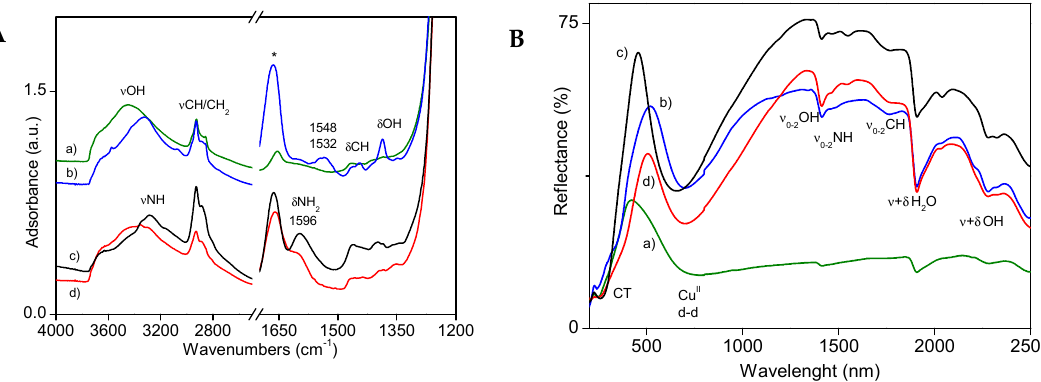
Figure 3. Infrared ( A ) and diffuse reflectance UV-Vis ( B ) spectra of (a) Si-Gly-CD-Cu; (b) Si-MonoAm-CD-Cu; (c) Si-DiAm-CD-Cu; (d) Si-TriAm-CD-Cu. Before infrared measurements samples were outgassed at 80 °C to remove adsorbed water and impurities. The peak labeled with * can be related to DMF residual solvent.